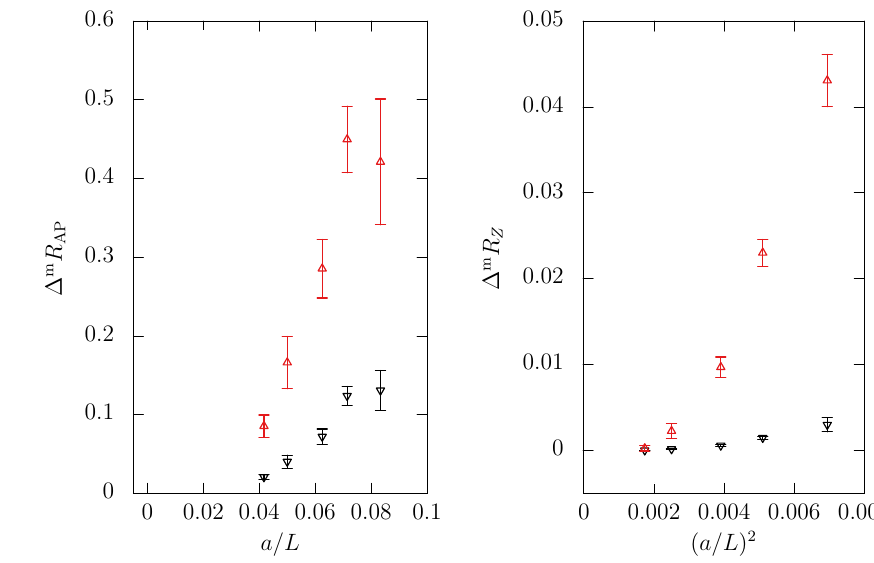
Fig. 6 O ( a ) ambiguities for R AP and R Z between different valence lines of constant physics. Black points show the differences between L (cid:6) 22 = 0 . 25 and L (cid:6) 22 = 0, while red points do so for L (cid:6) 22 = 1 and L (cid:6) 22 =